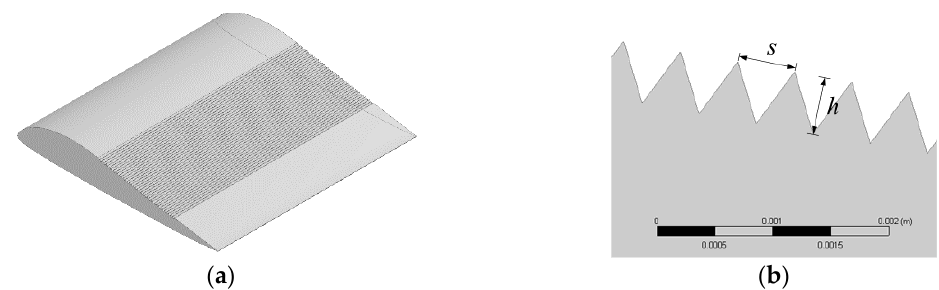
Figure 3. Geometry of the FF-77-W airfoil.